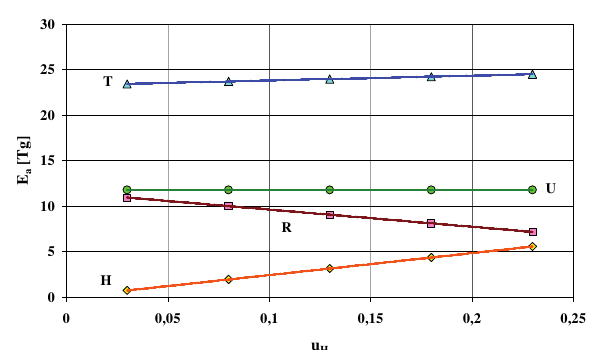
Fig. 14. Dependence of the national annual emission of carbon dioxide from passenger cars upon the share of road length travelled under the following model traffic conditions: U – urban, R – rural, H – on highways and expressways as well as T – under all